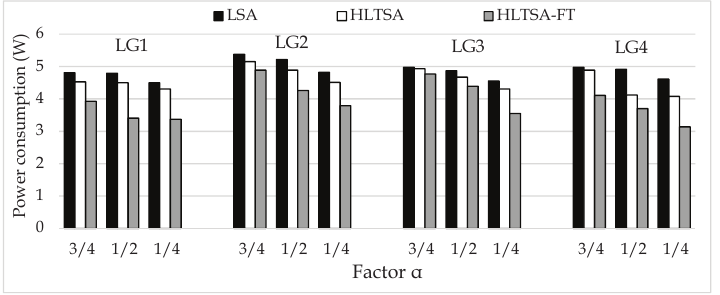
Figure 8. Comparison of average power consumption under different heuristics